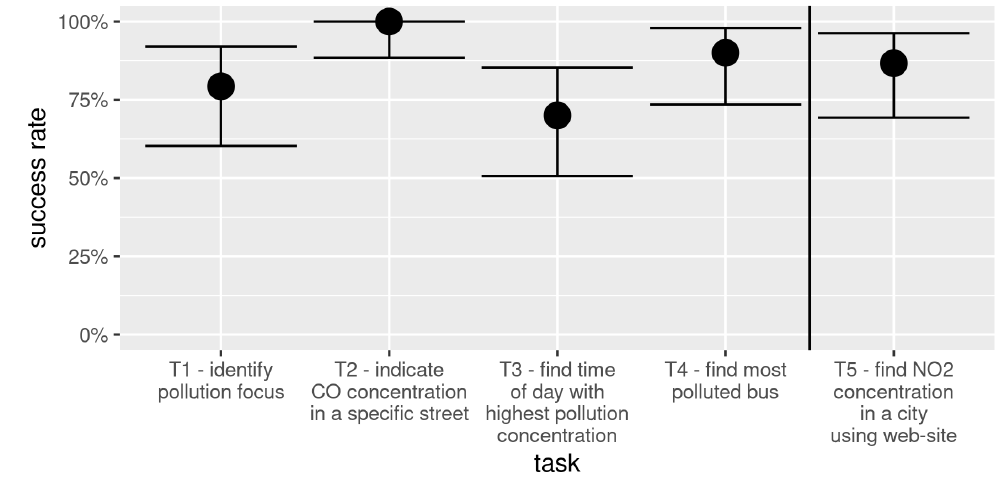
Figure 13. Plot of task completion’s success rate. Dots and error bars represent averages and 95% CI (binomial test),